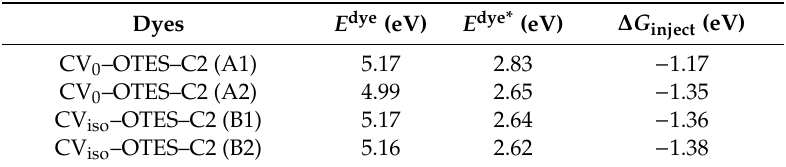
Table 3. Redox potential in the ground state ( E dye ), oxidation potential in the excited state ( E dye* ) and injection driving force ( ∆ G inject ) of isolated